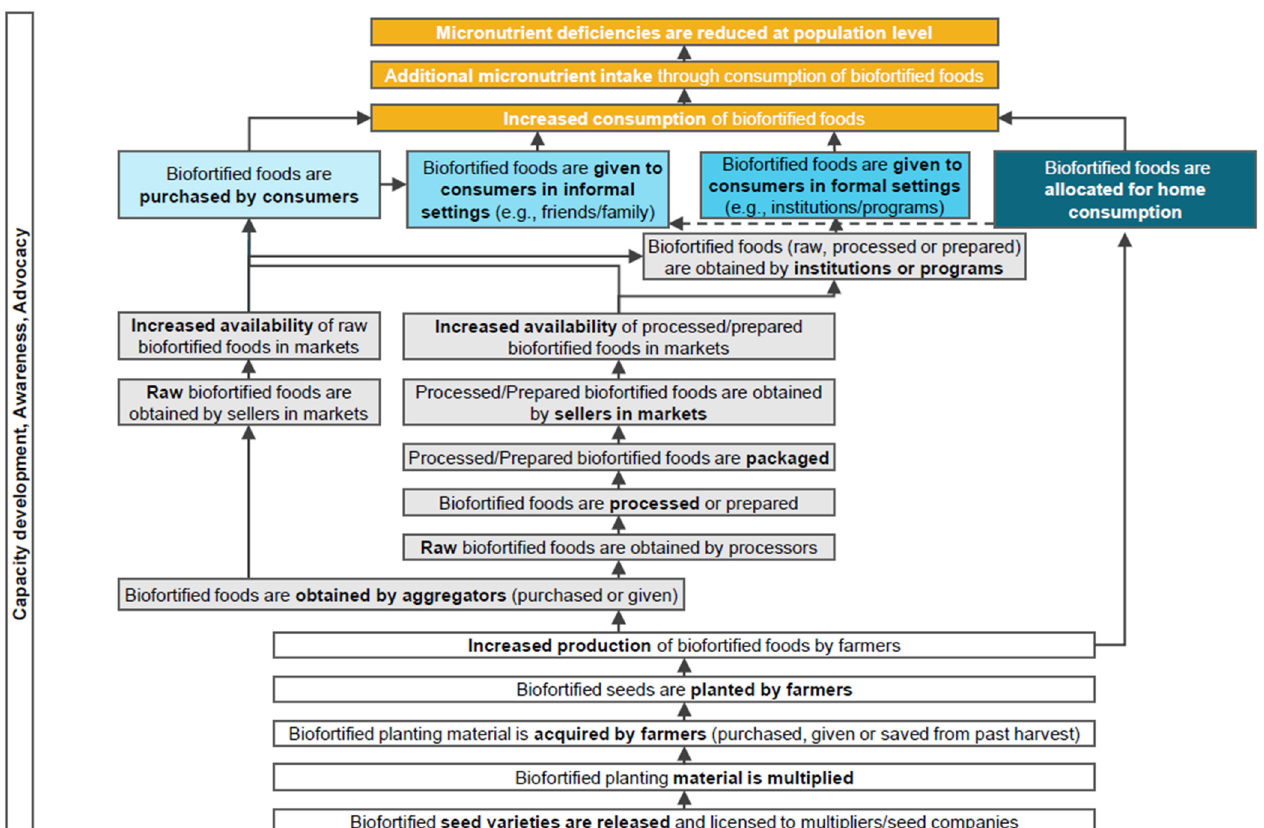
Figure 1. Biofortification Program Impact Pathway (PIP) framework [9]. Biofortified crop consump- tion may improve micronutrient deficiency via four Impact Pathways, highlighted by the blue boxes.